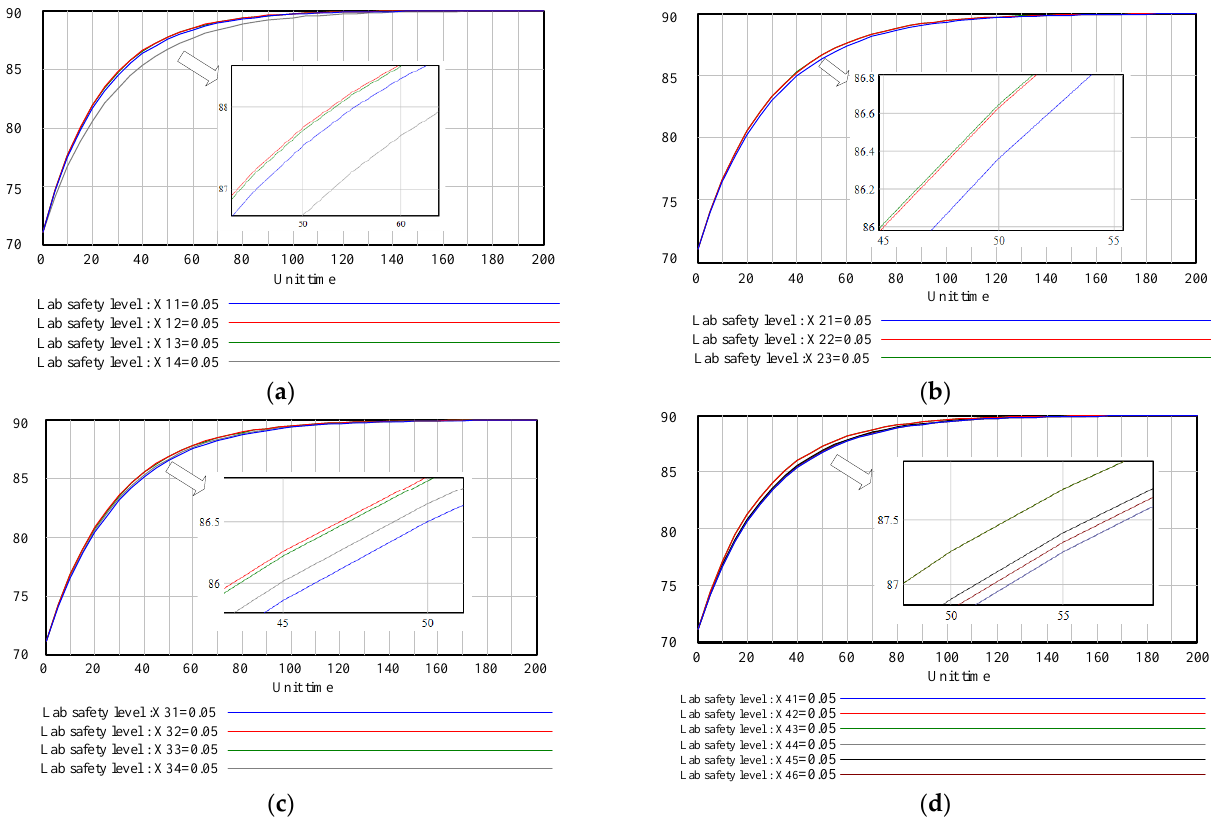
Figure 10. Laboratory safety level with different conversion rates: ( a ) human factors; ( b ) equipment factors; ( c ) environment factors; ( d ) management factors.